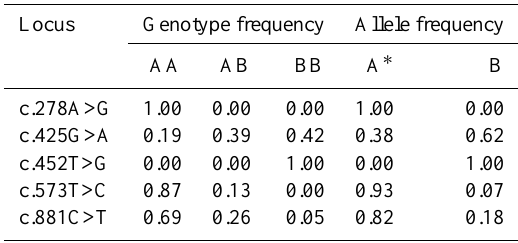
Figure 1. Genotyping SNPs of the porcine OPN gene (a) at c.425G>A locus with Hin6 I (b) at c.573T>C locus with Pfl23 II and (c) at c.881C>T locus with Tas I. The molecular marker of 100bp DNA ladder (M) and the OPN genotypes are indicated at the top of each lane.